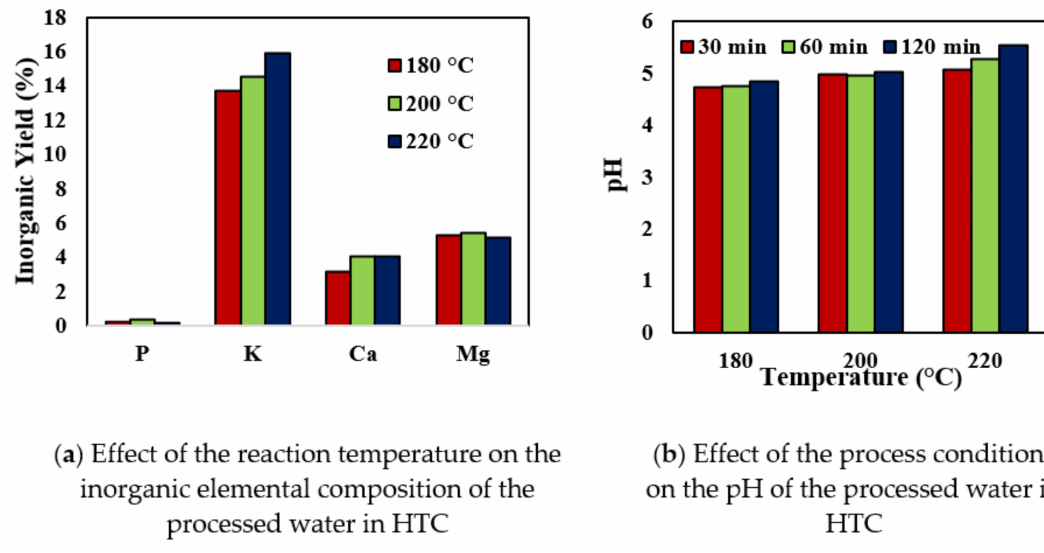
Figure 11. Effect of the reaction temperature on the inorganic elemental composition and pH of the processed